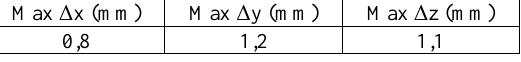
Table 3a. Coordinate change for other models according to the